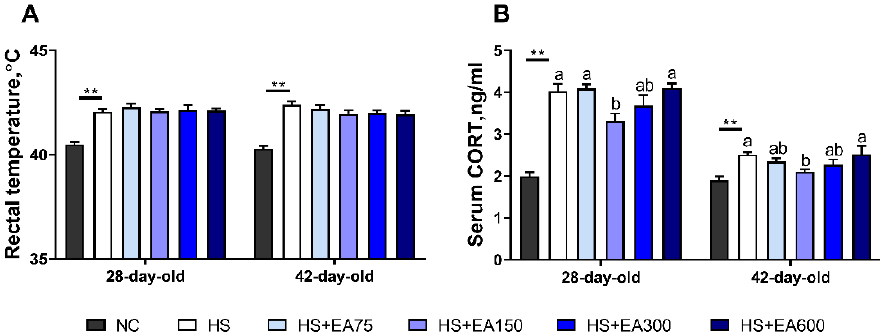
Figure 2. Validation of heat stress (HS) model of the broilers. ( A ) Rectal temperature. ( B ) Serum CORT, corticosterone. Data are presented as mean ± SEM (n = 6). NC (negative control) represents the broilers supplemented with a basal diet at normal temperature (23 ± 2 ◦ C). The broilers in the 5 experimental groups were supplemented with basal diets containing different levels of EA (0, 75, 150, 300, and 600 mg/kg) at HS temperature (35 ± 2 ◦ C), which are represented as HS, HS + EA75, HS + EA150, HS + EA300, and HS + EA600, respectively. Shared superscript letters indicate no significant difference ( p > 0.05). “**” indicates a significant difference between groups where p <